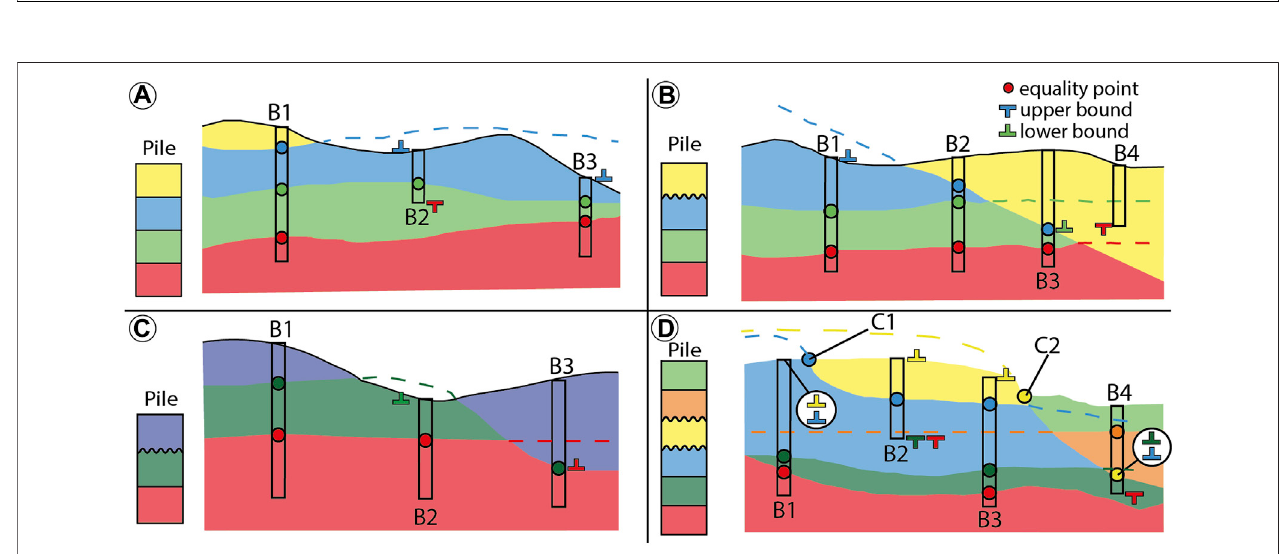
FIGURE 5 | Four examples (A – D) of how inequalities and equalities are extracted from boreholes and fi eld data. (B) indicates borehole information and (C) a unit contact(e.g.,observedonthe fi eld). Foreach example,astratigraphic pileisde fi nedtoindicate therelationshipsbetweentheunits and thenatureofthesurfacecontact (straight line is onlap and corrugated is erode). Dashed lines represent simulated surfaces before applying erosion rules (see Section 2.3 ).